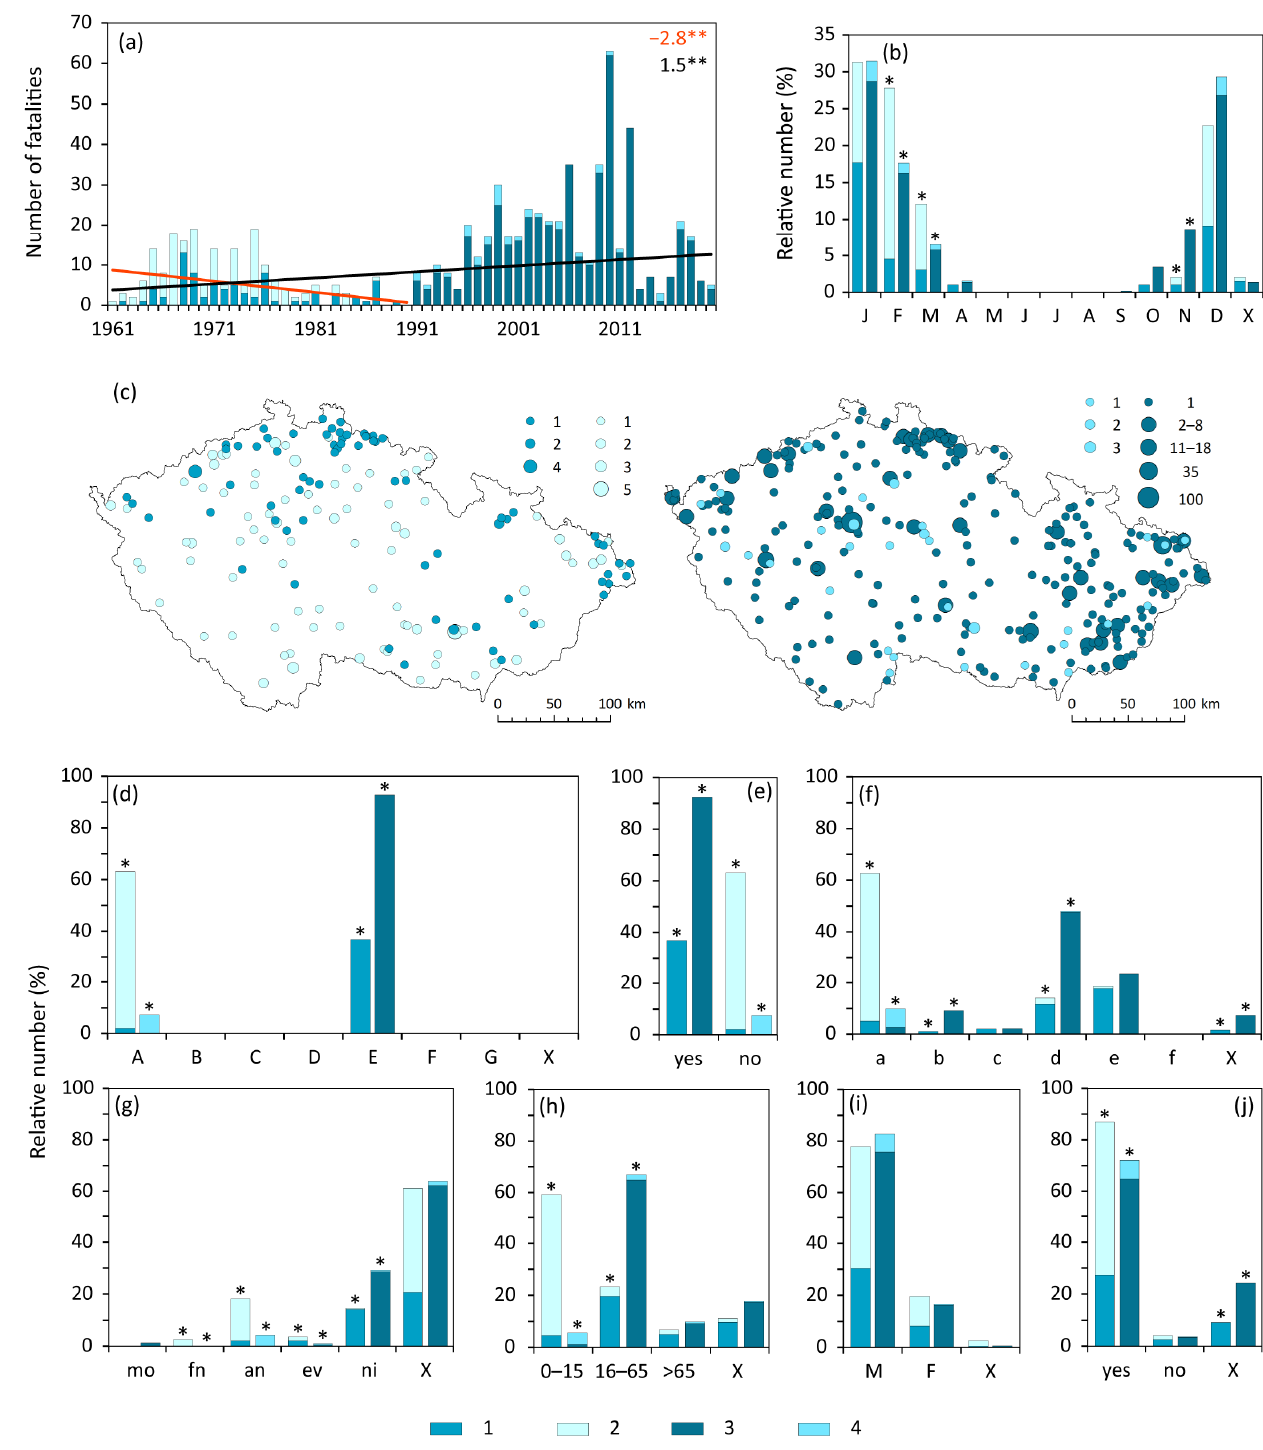
Figure 6. Characteristics of frost-related fatalities in the Czech Republic during the 1961–1990 (1—cold spell, 2—ice) and 1991–2020 (3—cold spell, 4—ice) periods. ( a ) Fluctuations with linear trends (top right in fatalities/10 years for 1961–1990 and 1961–2020, trends with ** are significant for p < 0.05); ( b ) annual variation; ( c ) spatial distribution (seven fatalities in 1961–1990 and nine fatalities in 1991–2020 lack exact location); ( d ) cause of death; ( e ) type of fatality (direct); ( f ) place of death; ( g ) time of day; ( h ) age; ( i ) gender; ( j ) behaviour (hazardous). For an explanation of symbols and abbreviations see Figure 2.